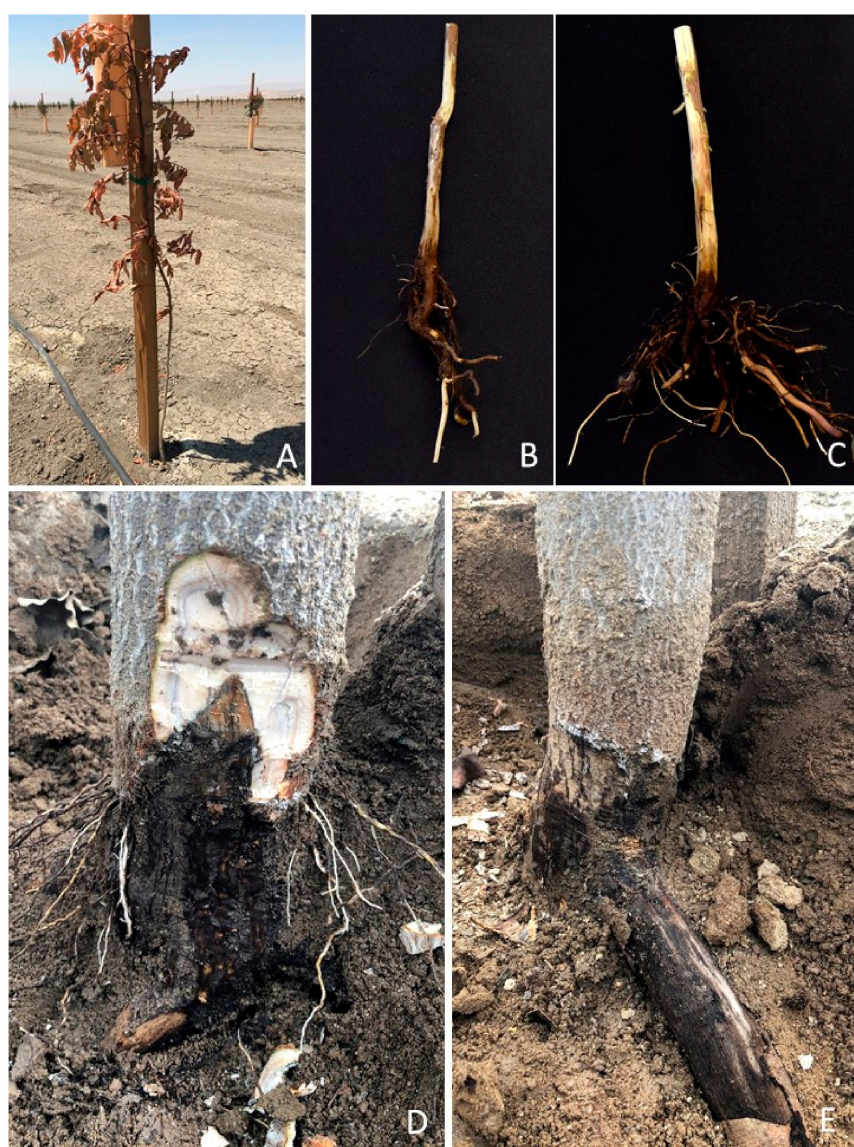
Figure 1. Symptoms in pistachio rootstocks associated with Macrophomina phaseolina ; ( A ) wilting and death of unbudded University of California Berkeley I (UCBI) pistachio rootstocks; ( B , C ) associated crown rot symptom; ( D , E ) pistachio tree showing crown rot and black